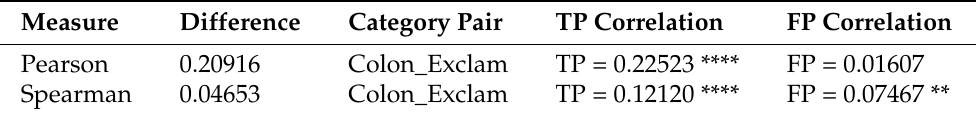
Table 12. Colons and Exclamations in Suicidal.